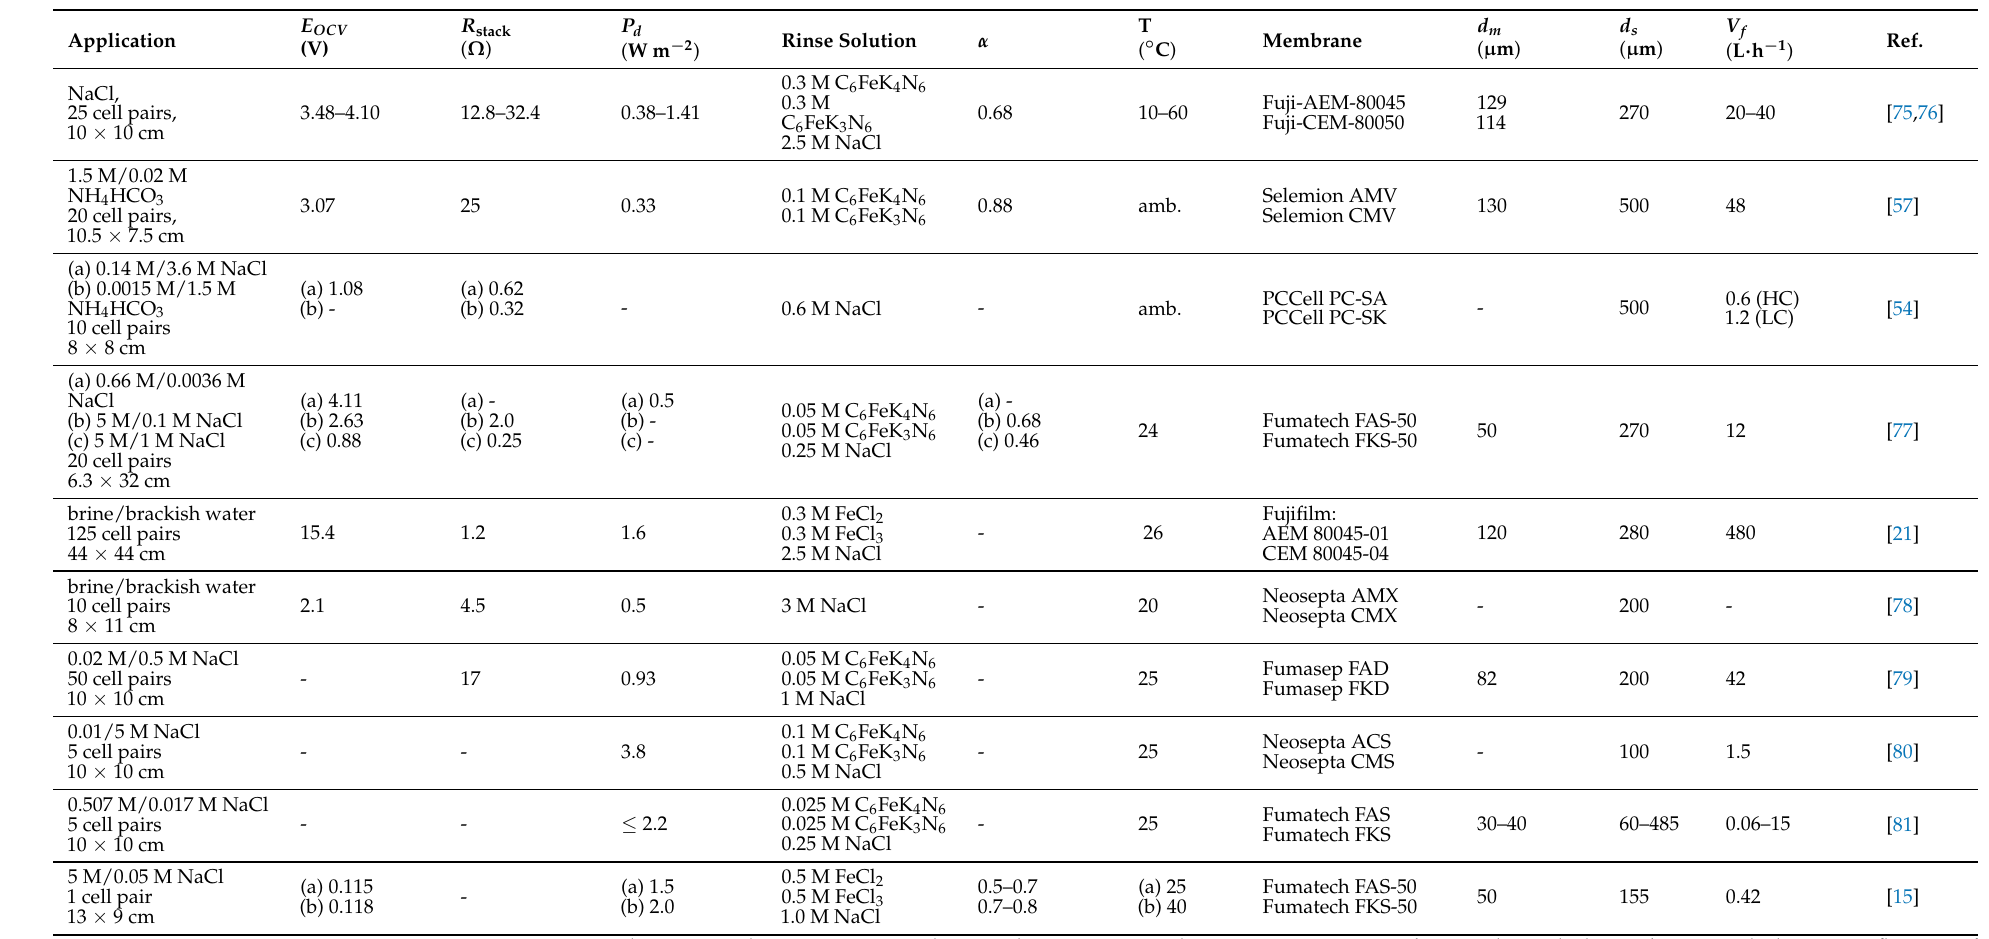
Table 2. Studies on RED using commercial